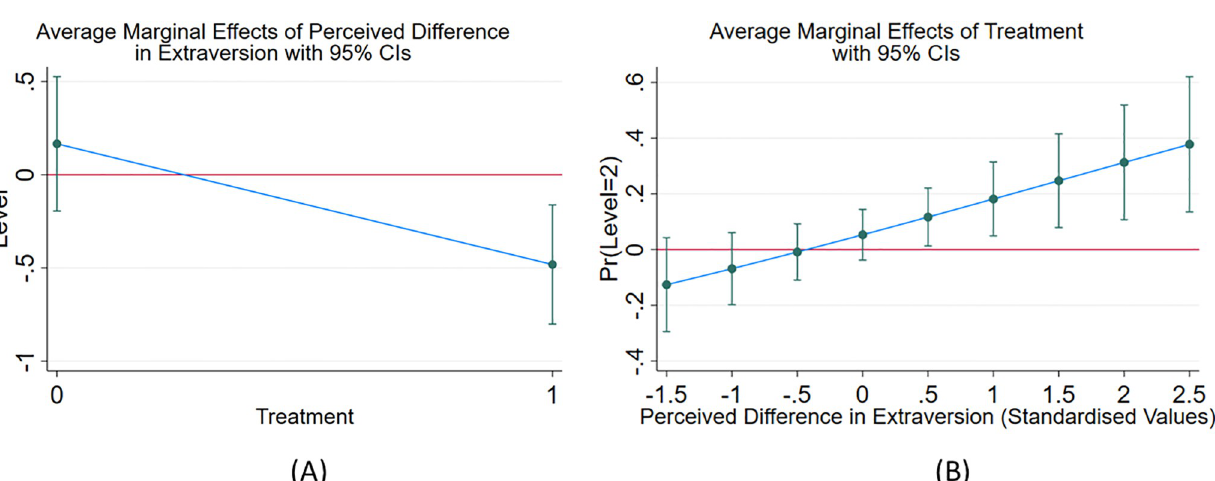
PLOS ONE | https://doi.org/10.1371/journal.pone.0269523 September 2,